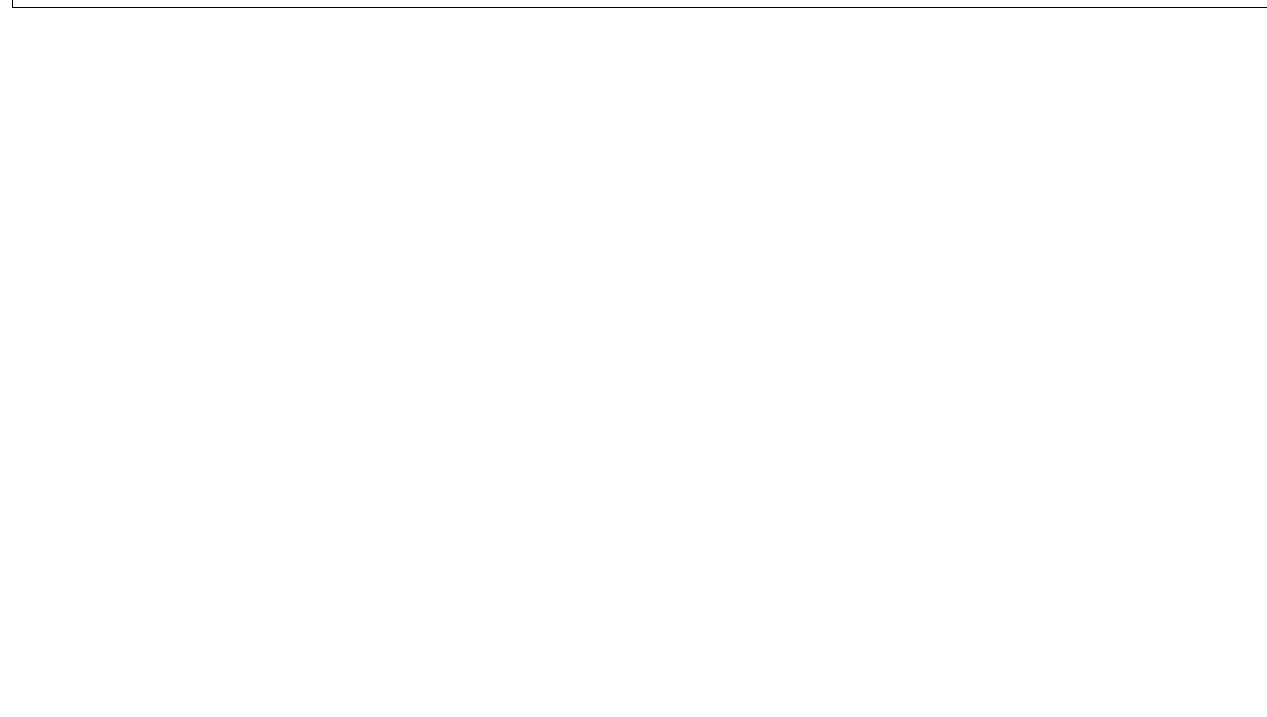
FIGUREA2 |The impact of simulator parameters on the power of the S f statistic. All trials were performed at 200 generations after the application of selection pressure and with all other simulator parameters as default, as per the Methods. A 1% false positive rate is also used to identify significance, as described in the Methods. (A) The impact of average read depth on power. As can be seen, approximately 20–30 × coverage per population is sufficient to achieve maximal power. (B) The impact of base-calling error rates on power. Due to the removal of SNPs with less than